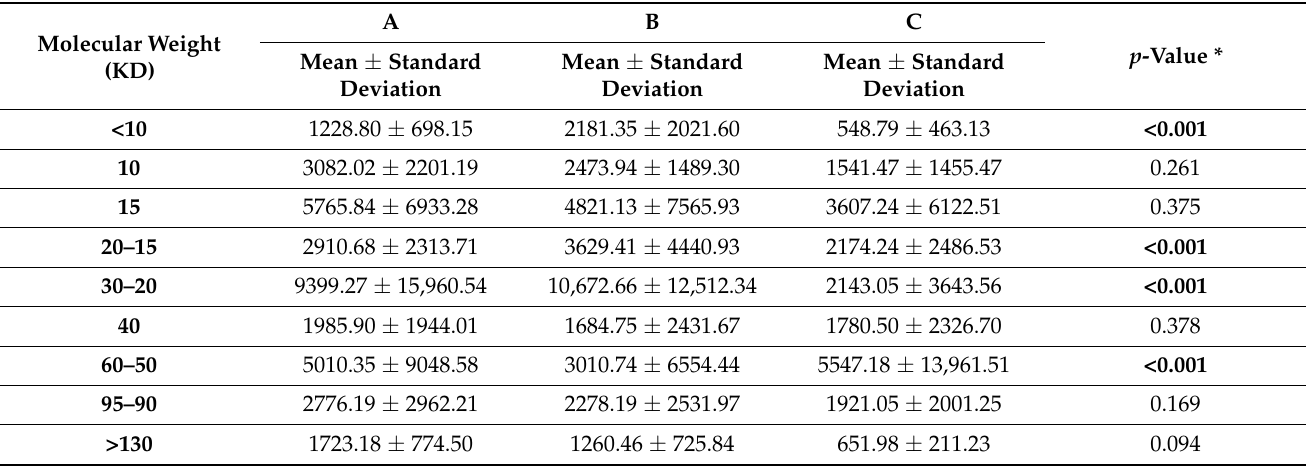
Table 3. Mean concentrations of the proteins in the three